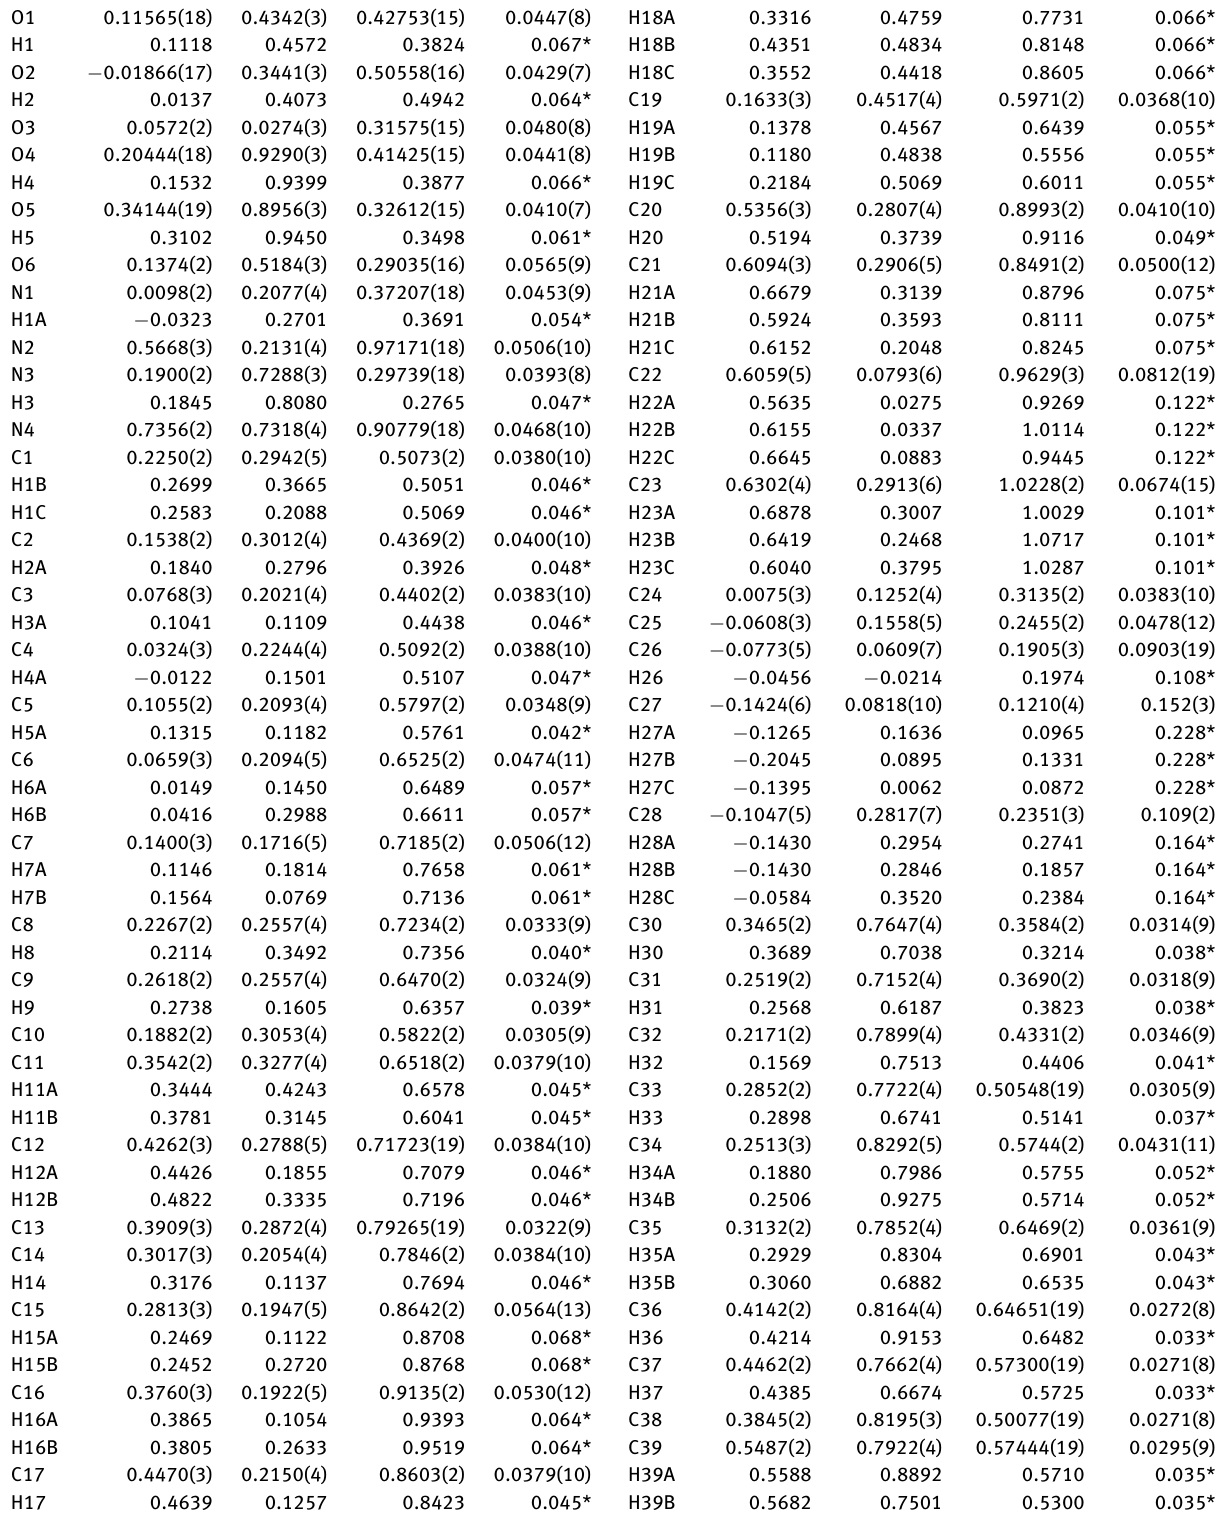
Table 2: Fractional atomic coordinates and isotropic or equivalent isotropic displacement parameters (Å 2